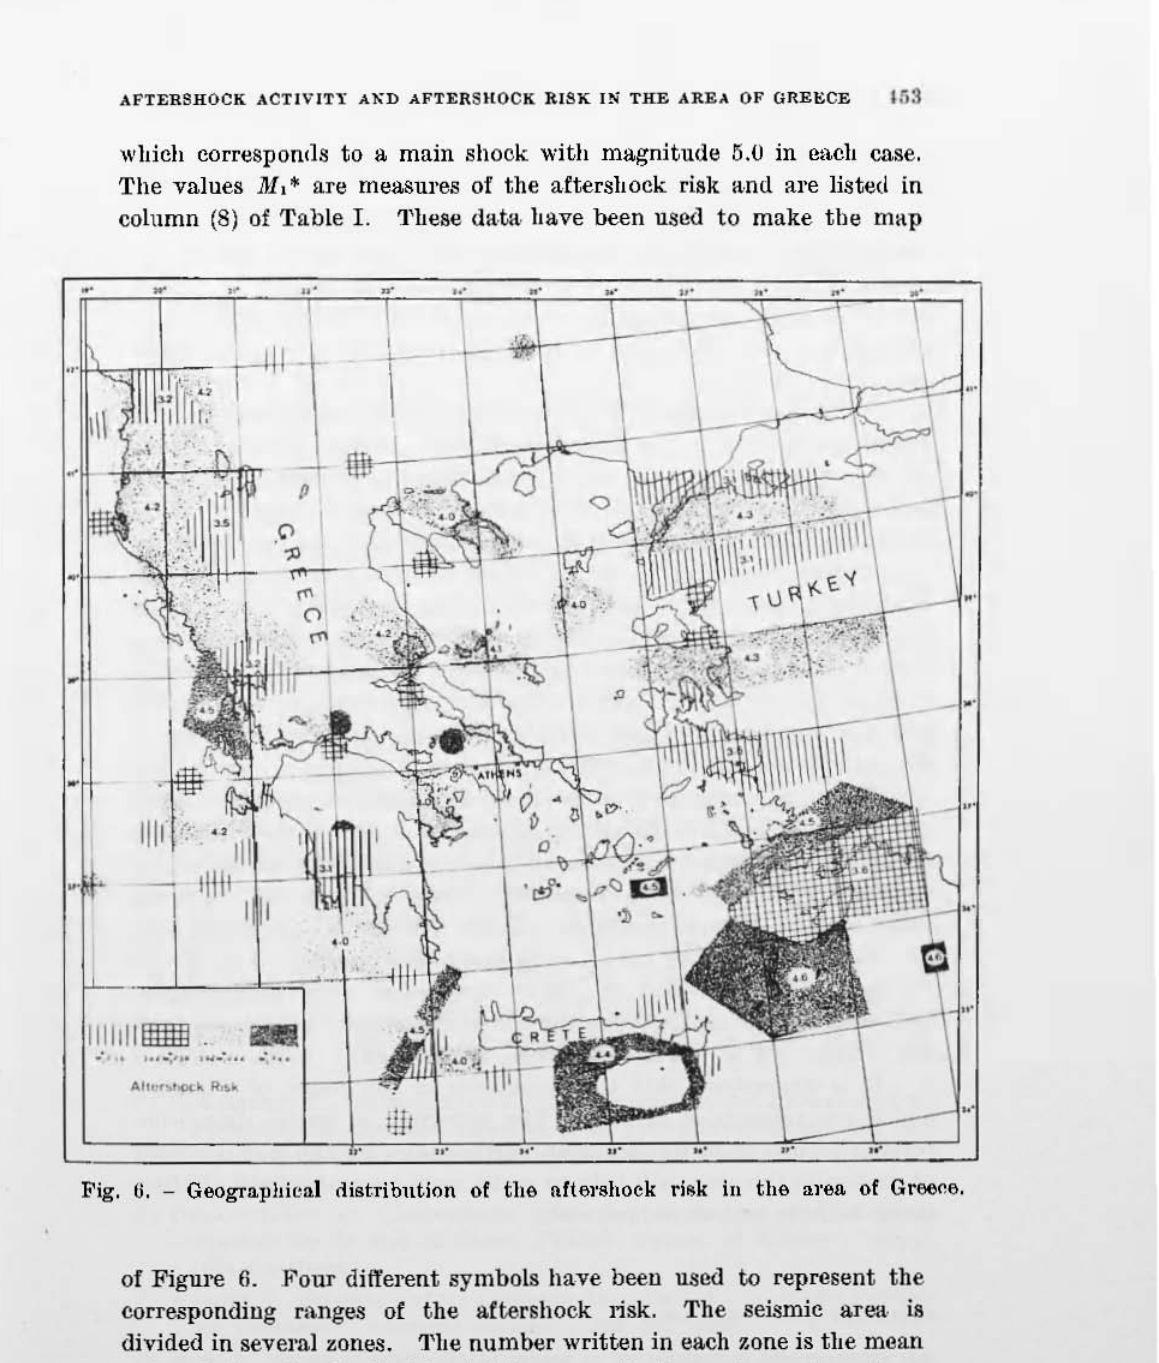
or Figure G. .F'OUT clilferent symbols ha-ve beeu usoo to represent the correspondiug ra.nges of the aft-ershock